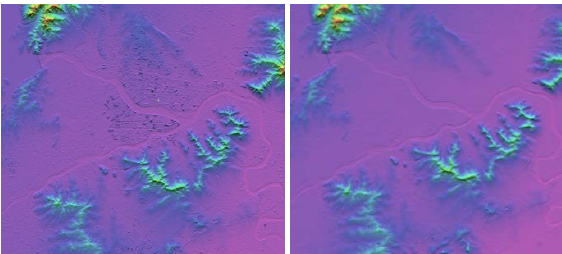
Figure 5. The thumbnail images of the DSM (left) and DTM (right) Product CPs Grid Table 7. The DSM and DTM accuracy (unit: meter) In addition to the DSM and DTM, digital topographic map (Figure 6) and ortho-image map (Figure 7) are also produced, and their accuracy meets national mapping requirements.